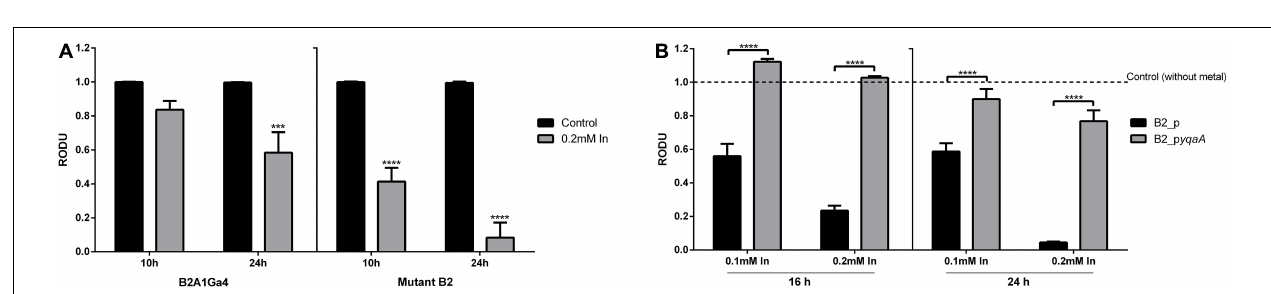
FIGURE 4 | Growth of strains B2_p and B2_p yqaA at 16 h (A) and 24 h (B) of incubation at 25 ◦ C. Data shown are the mean values ( ± standard deviations) obtained from three independent experiments. ***, ****Significantly different between the two strains, p < 0.001 and p < 0.0001, respectively.